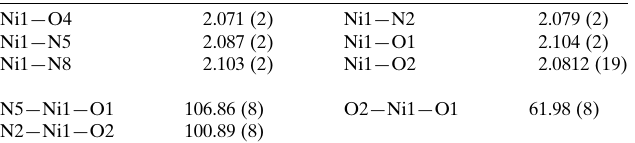
Table 1 Selected geometric parameters (A˚ , (cid:3)